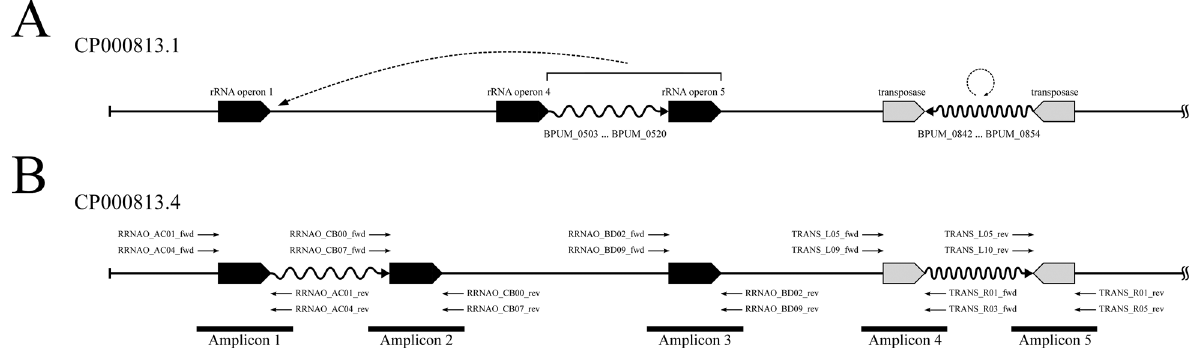
Fig 2. Proposed B . pumilus SAFR-032 genome rearrangements (A) and scheme of their validation (B). Not to scale. rRNA operons and transposase genes are shown as black- and grey-filled rectangular arrows, respectively. The problematic fragments between sequence repeats are shown as waved arrows. The proposed sequence rearrangements are shown as dashed arrows. Relative positions of amplification primers are shown by thin straight arrows. The span of PCR amplicons is marked by thick black lines. Sequence start corresponds to the first codon of dnaA